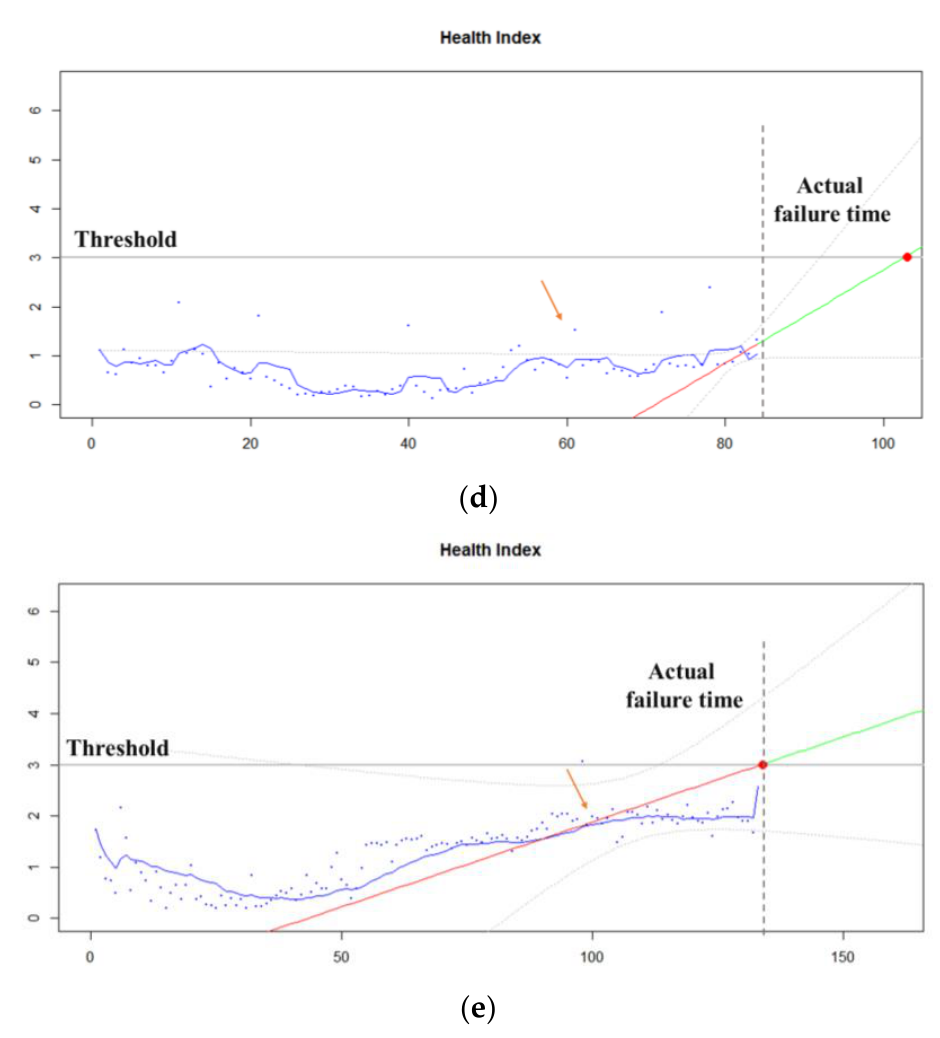
Figure 8. The result of robot arm data. ( a ) Constructed HI model on robot arm No. 1; ( b ) Constructed HI model on robot arm No. 2; ( c ) Constructed HI model on robot arm No. 3; ( d ) Constructed HI model on robot arm No. 4; ( e ) Constructed HI model on robot arm No. 5.